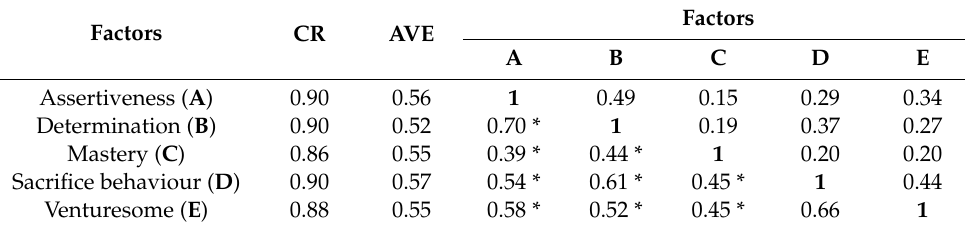
Factors A B C D E